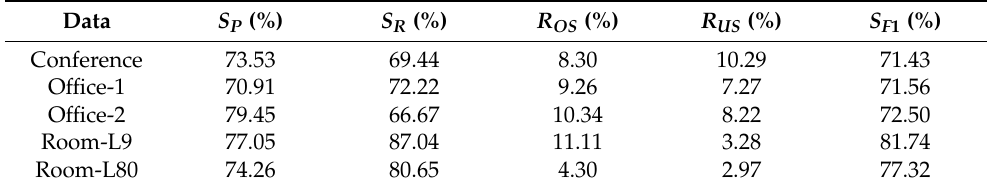
Table 3. Quantitative results of 3D indoor